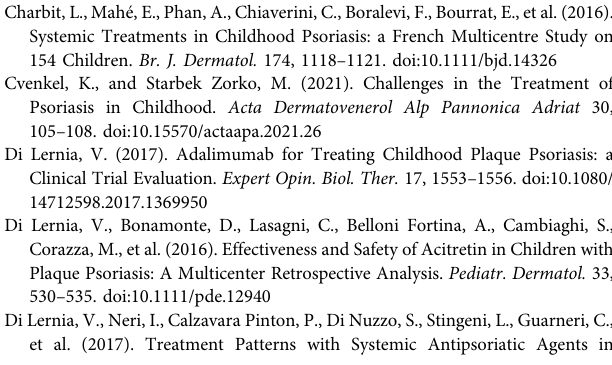
No of Number Needed (95% CI) Participants ** to Treat (NNT) Assumed risk Corresponding